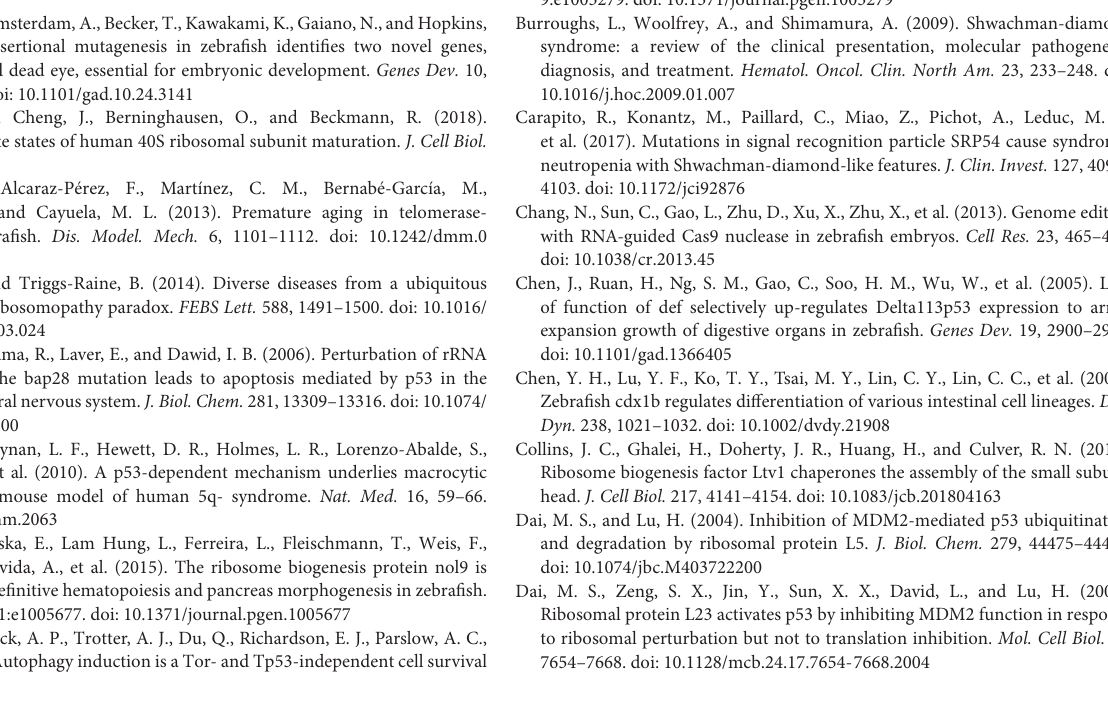
Supplementary Figure 1 | Ltv1 is conserved among human, mouse and zebrafish. Alignment of Ltv1 protein sequence from human, mouse, and zebrafish.